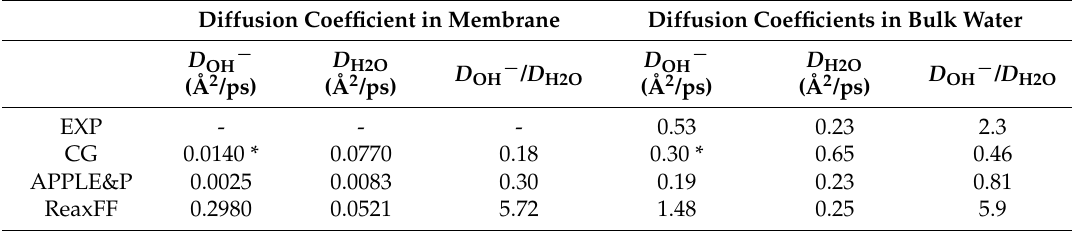
Table 3. Diffusion coefficient of anion and H 2 O and the corresponding